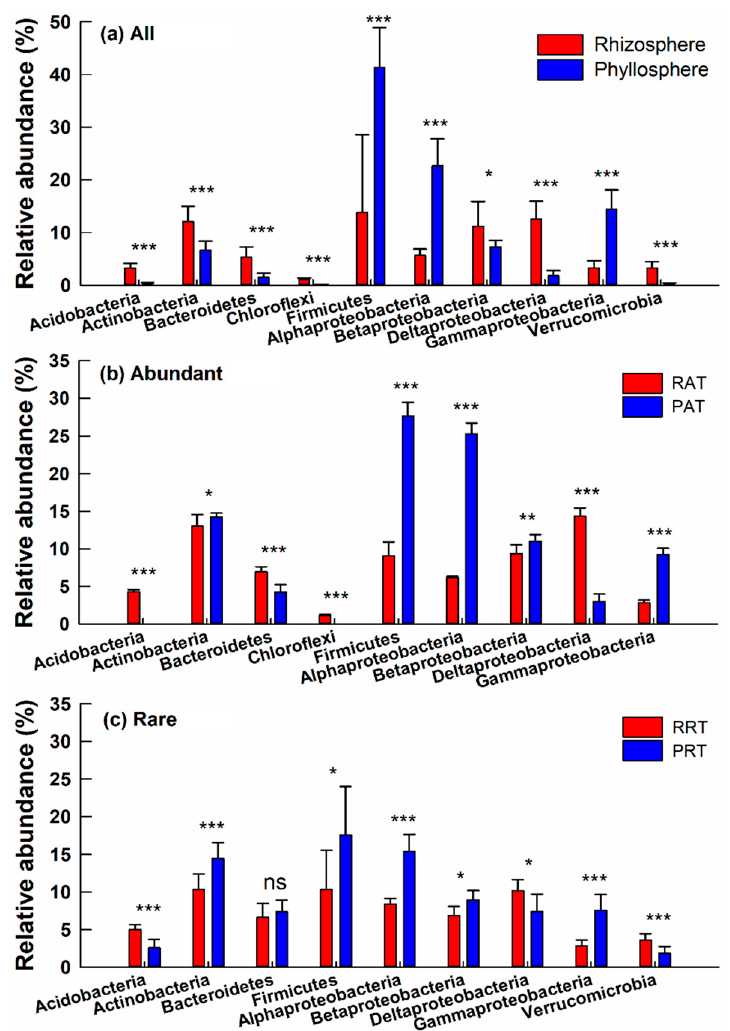
Figure 3. Relative abundance of dominant bacterial communities at the level of phyla / subphyla in di ff erent epiphytic compartments. ( a ) All, whole bacteria taxa; ( b ) Abundant, abundant bacteria taxa; ( c ) Rare, rare bacteria taxa. Only phyla / subphyla with relative abundance > 1.0% were shown, and phyla with relative abundance < 1% were designated as minor. Stars indicate significant di ff erences between rhizosphere and phyllosphere ( n = 12 for each group) (two-tailed independent-sample t -test, *, p < 0.05; **, p < 0.01; ***, p < 0.001; ns, no significance). RAT, rhizosphere abundant taxa; PAT, phyllosphere abundant taxa; RRT, rhizosphere rare taxa; PRT, phyllosphere rare taxa.